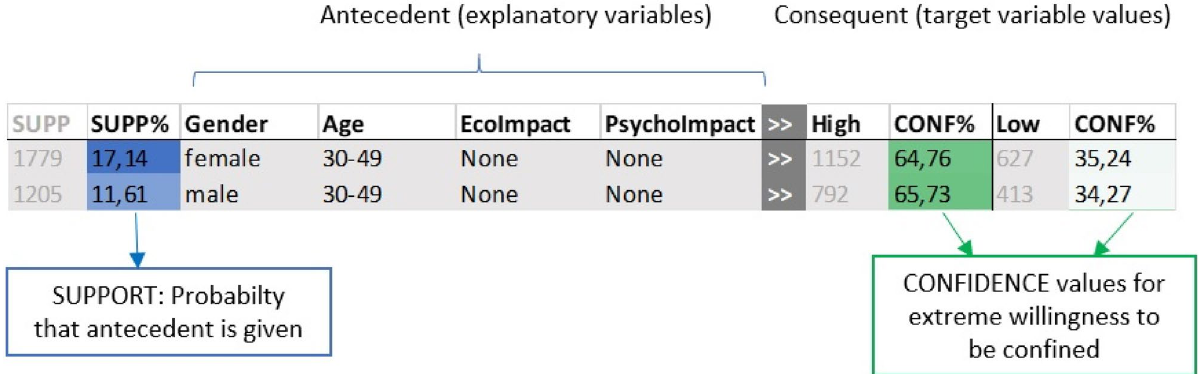
Figure 6. Example of two of the patterns identified by our pattern extraction